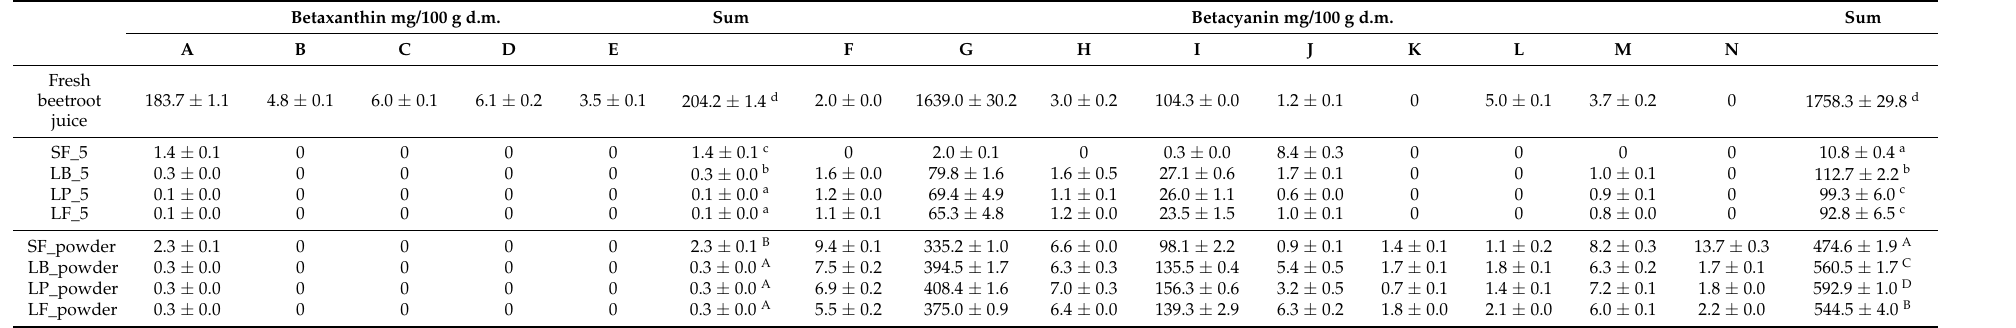
Table 3. HPLC analysis